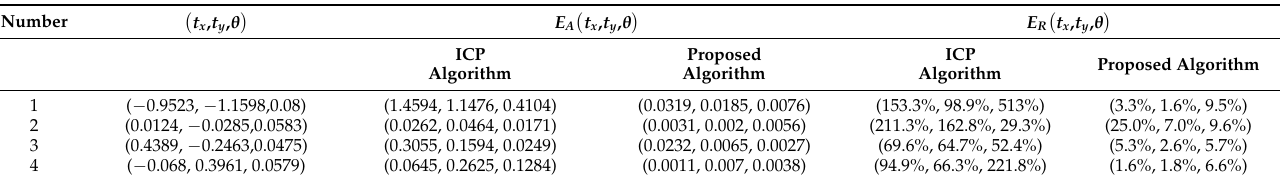
Table 3. Comparison of lidar data registration results.